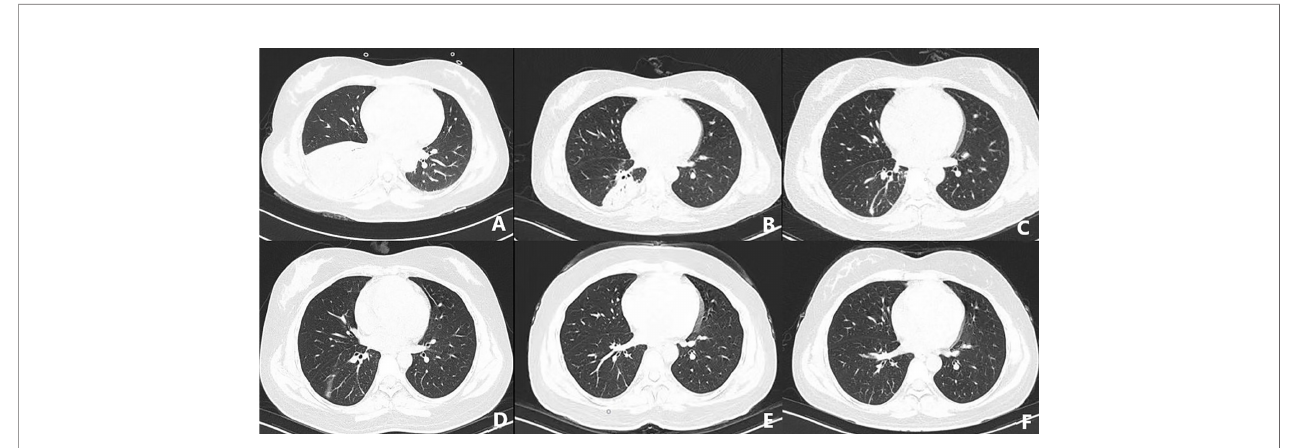
FIGURE 2 | CT-scan of the lungs in the early stage of disease (A) , after treatment (B – D) , review after one month (E) , and review after three months (F) .